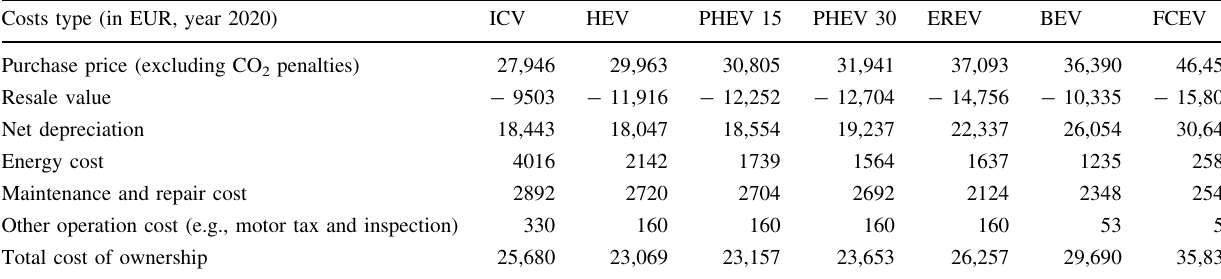
Table 8 Cost breakdown for different powertrain options (in EUR) [300]